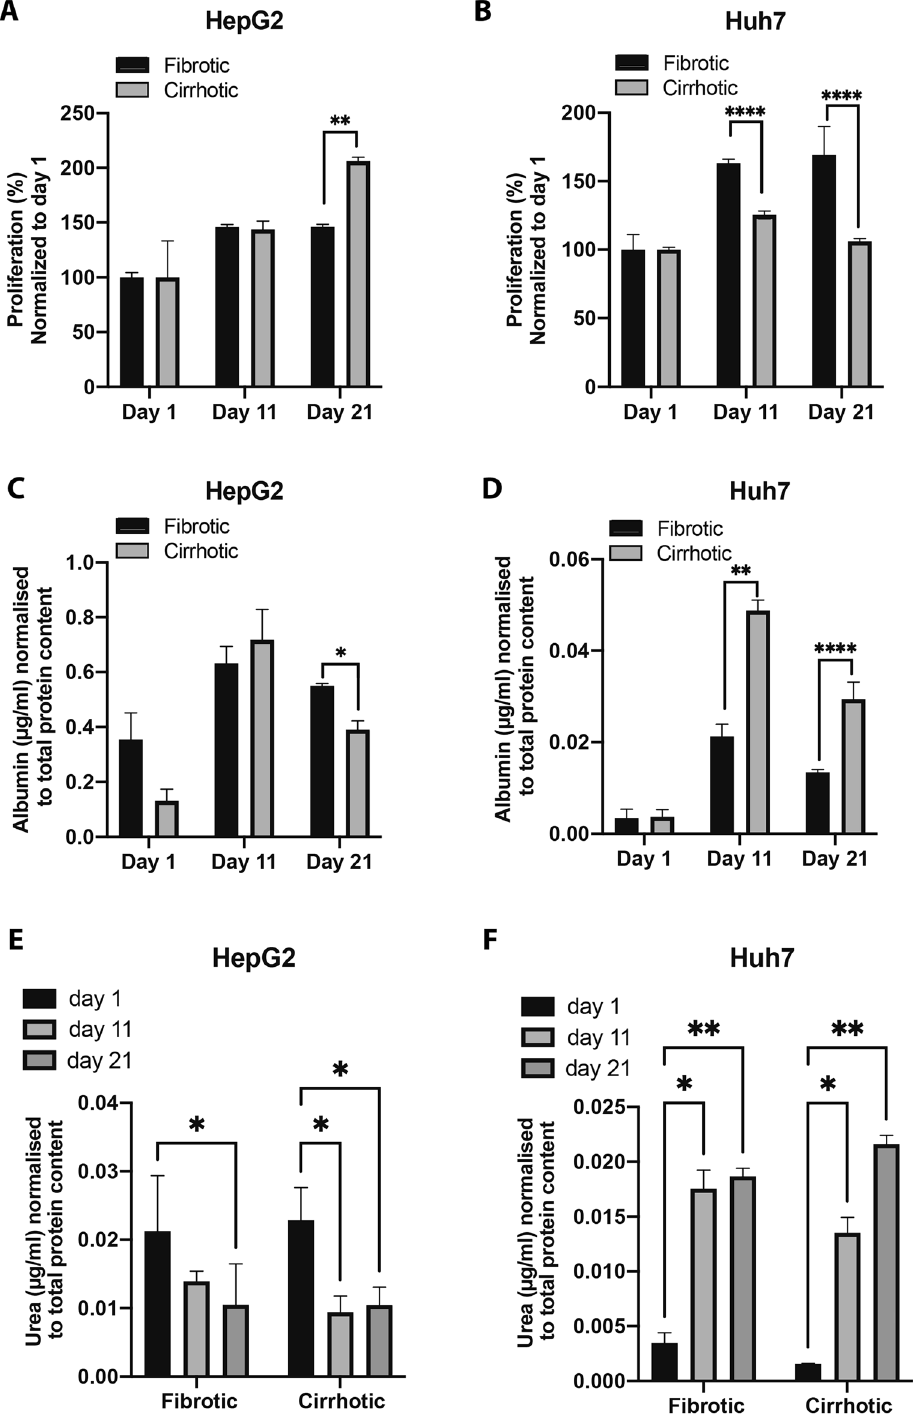
Figure 2. Viability, albumin, and urea content of cells grown in the 3D hydrogels resembling a fibrotic and cirrhotic liver. ( A ) Proliferation of HepG2 and ( B ) Huh7 cells. ( C ) Albumin normalised to total protein content of HepG2 and ( D ) Huh7 cells. ( E ) Urea normalised to total protein for HepG2 and ( F ) Huh7 cells. (n = 3, error bars = SD, ***p < 0.001, **p < 0.01, *p <